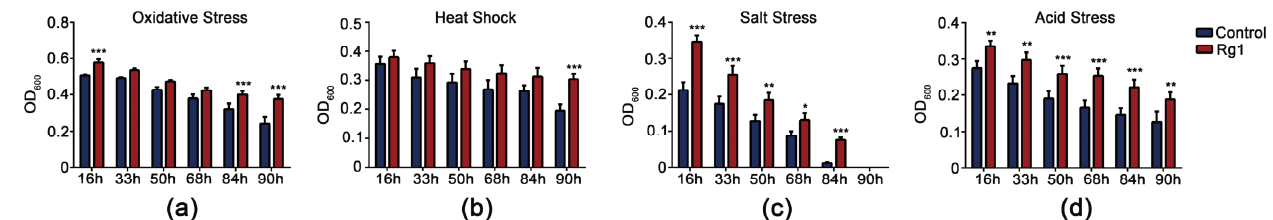
Figure 4. Effect of Rg1 on stress-resistance of S. cerevisiae cells. Analysis of yeast cells OD value under oxidative ( a ), high-temperature ( b ), high-salt ( c ), and acid stress ( d ) with or without Rg1 (180 μg/mL) treatment. Data are expressed as the mean ± SD; n = 3. Compared with untreated controls, * p < 0.05, ** p < 0.01, *** p < 0.001.